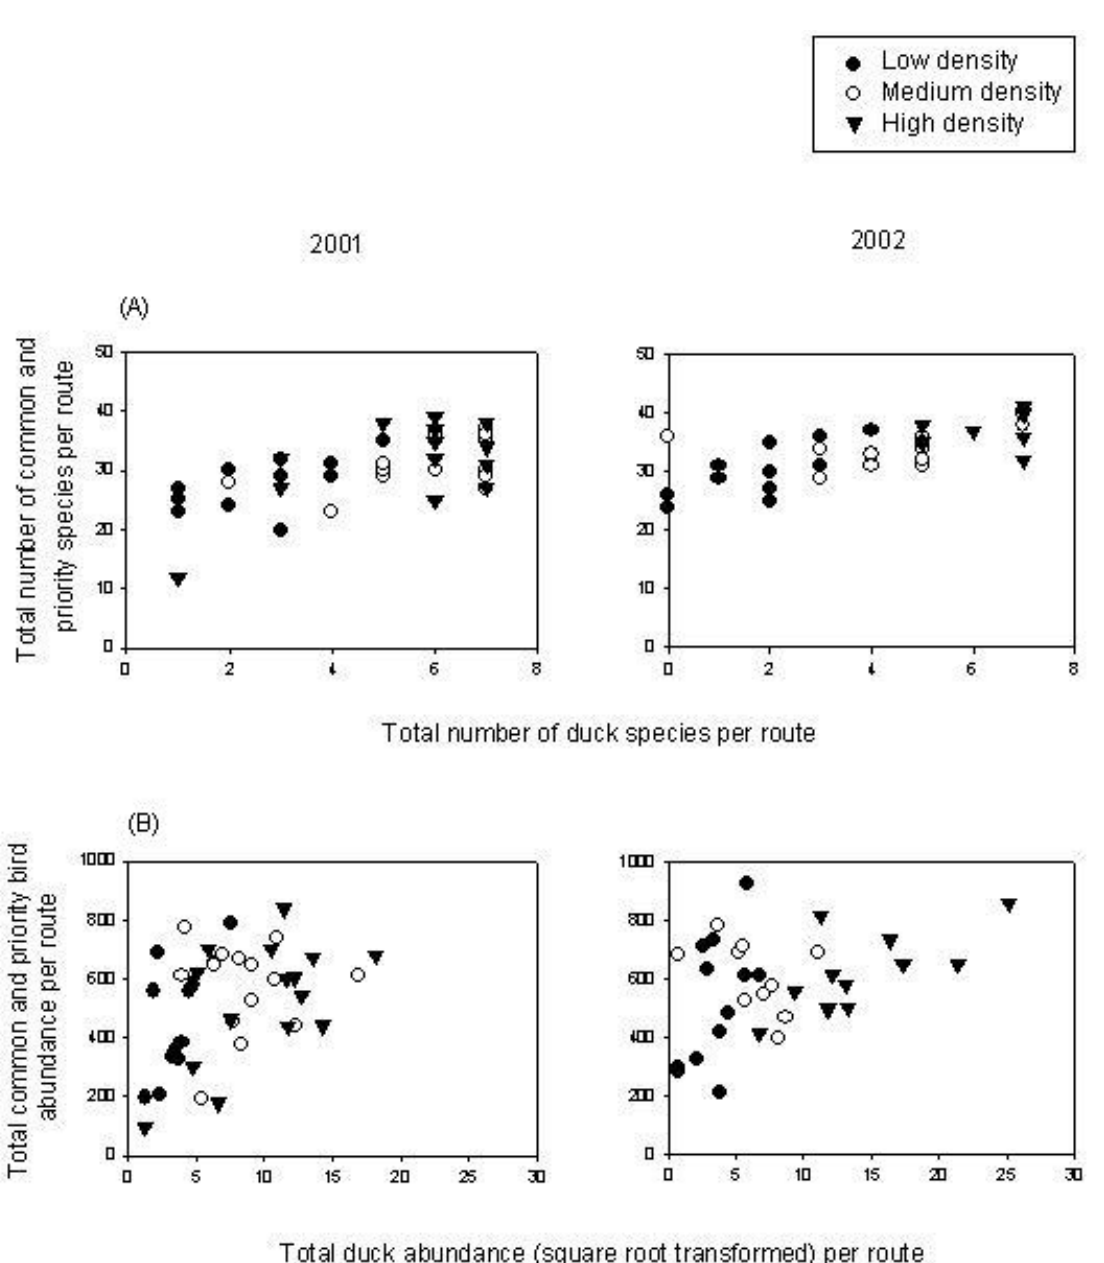
Fig. 2. Route-level relationships between the seven duck species used to create the model for the predicted waterfowl breeding distribution and all other grassland bird species encountered along point transect routes in southern Saskatchewan in 2001 (49 species) and 2002 (45 species). (A) Total number of common and priority species per route as a function of total duck species per route. (B) Total abundance of common and priority species per route as a function of total duck abundance per route. Symbols indicate predicted waterfowl breeding